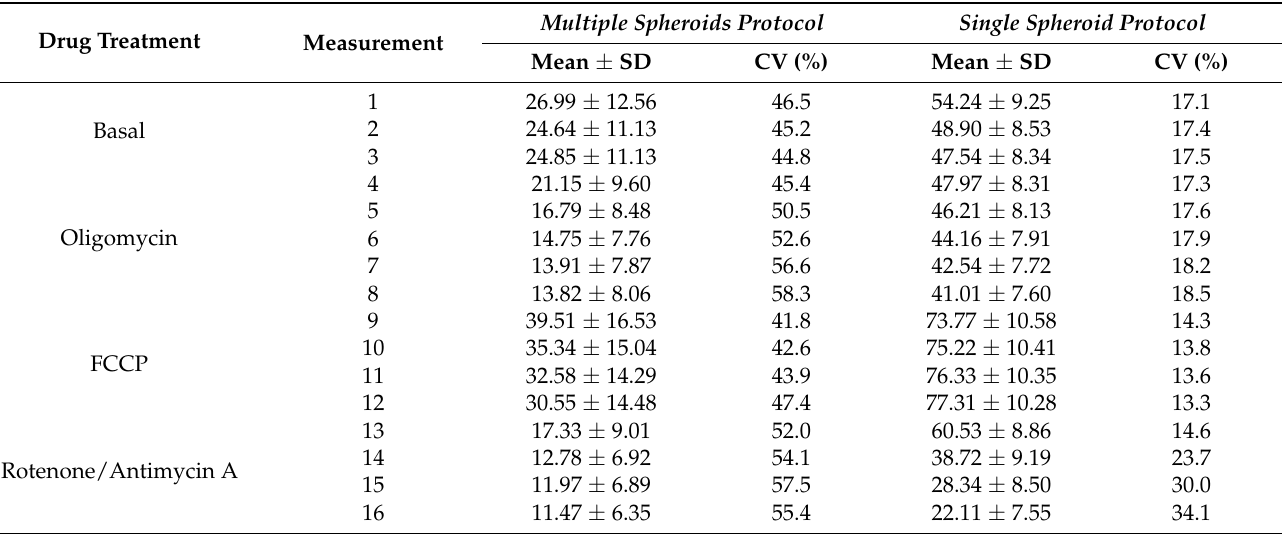
Table 3. Mean, standard deviation (SD), and the Coefficient of Variation (CV) of Oxygen Consumption Rate (OCR) measured during Mito Stress Test on spheroids formed with the Multiple Spheroids Protocol and Single Spheroid Protocol (10,000 cells/well) in the MCF7 cell line. Multiple Spheroids Protocol Single Spheroid Protocol Drug Treatment Measurement Mean ±